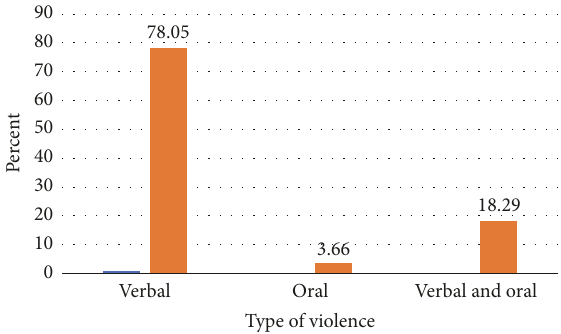
Figure 1: Antenatal care follow-up history of participants in Arba Minch Zuria District, Ethiopia, 2017.